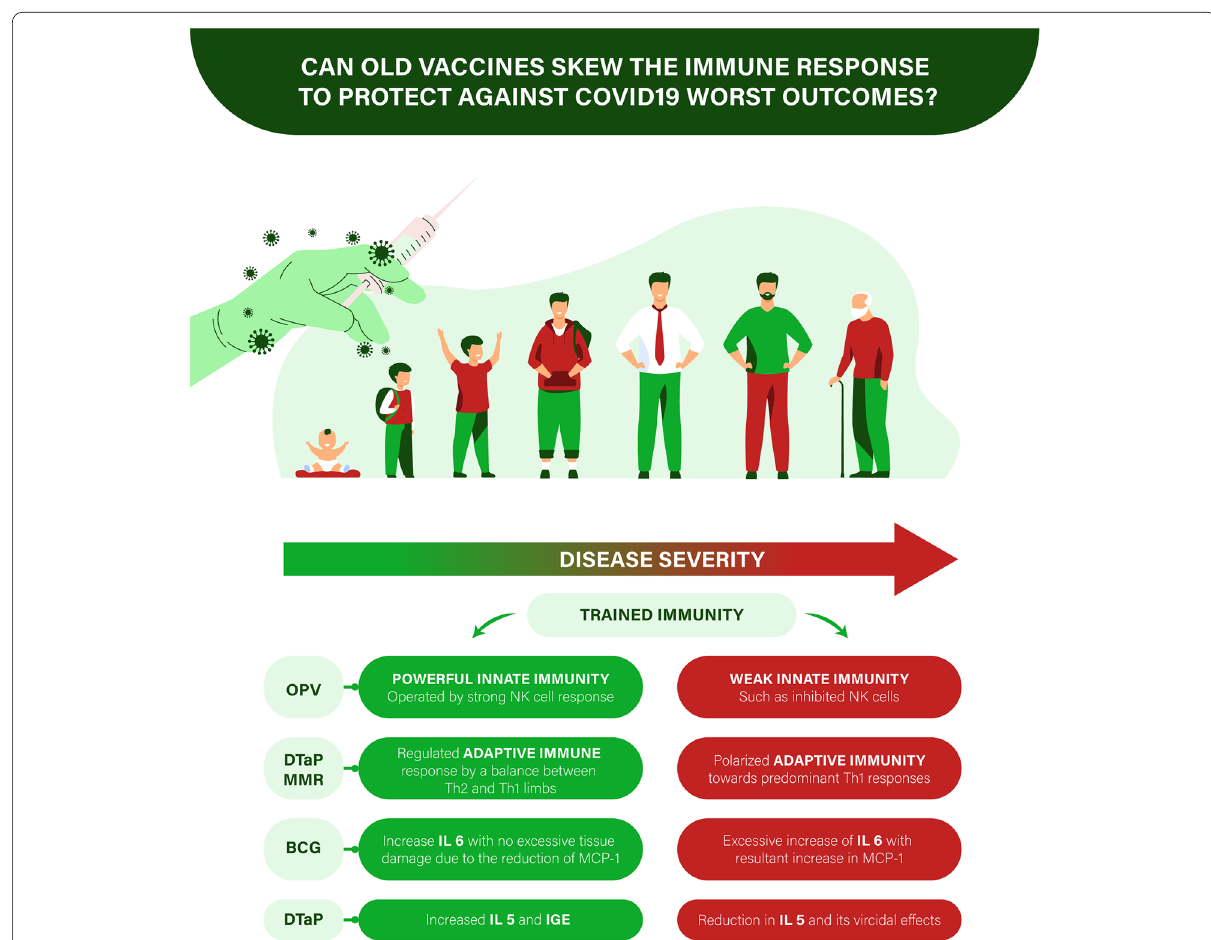
Fig. 1 Can Old vaccines skew the immune response to protect against COVID‑19 worst outcomes? Abbreviations: BCG, Bacillus Calmette–Guérin; COVID‑19, coronavirus disease 2019; DTaP, diphtheria, tetanus, acellular pertussis; CD, cluster of differentiation; Ig, immunoglobulin; IL, interleukin; MCP, monocyte chemotactic protein; MMR, measles mumps rubella; OPV, oral polio vaccine; Th, T